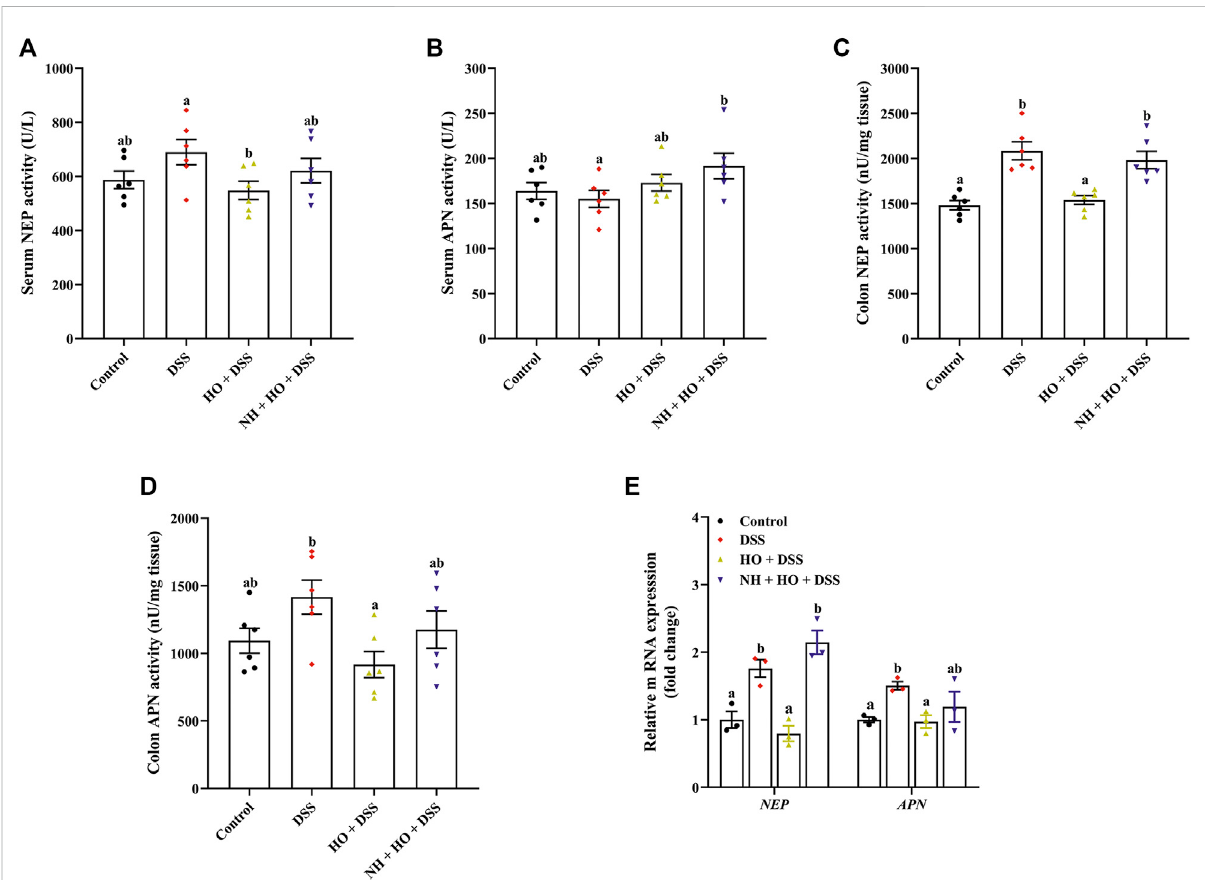
FIGURE 7 Effects of HO treatment on expression of NEP and APN in the serum and colon in DSS-exposed mice. (A) Serum NEP activity. (B) Serum APN activity. (C) Colon NEP activity. (D) Colon APN activity. (E) Relative gene expression of NEP and APN in the colon. The data are expressed as mean ± S.E.M. ( n = 3 – 6). Bars with different letters represent signi fi cant differences between groups by Fish ’ s LSD test ( p <